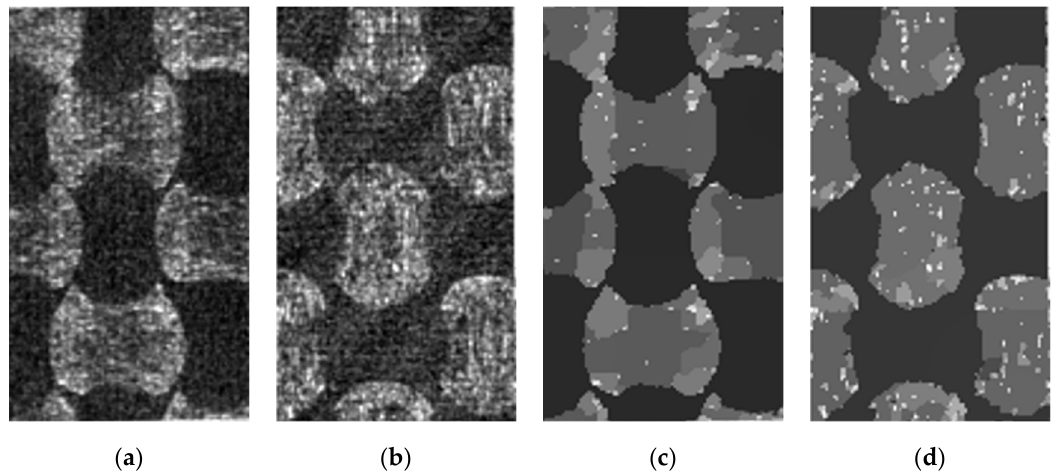
Figure 5. Downsampled results of the orientation analysis ( a , b ) and the corresponding results of Mumford–Shah functional minimization ( c , d ).